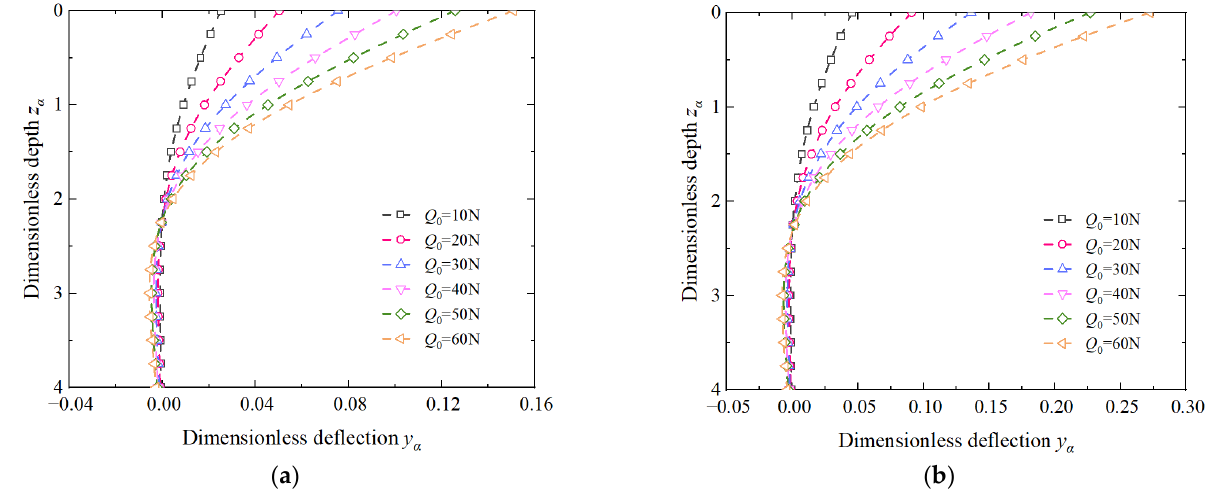
Figure 8. Comparisons of dimensionless bending moment profiles in lateral static loading tests. ( a ) in sloping ground; ( b ) in sloping ground.